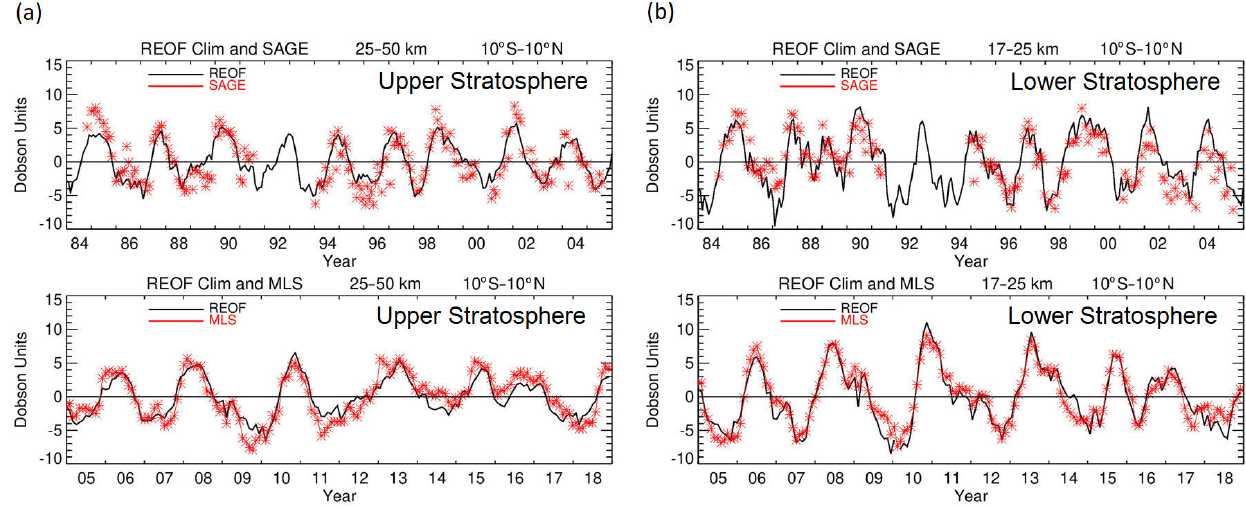
Figure 7. (a) The top panel is zonal-mean upper-stratospheric column ozone (in Dobson units) for the REOF climatology (black curve) and deseasonalized SAGE II (red asterisks) spanning from 1984 to 2005 and averaged between 10 ◦ S and 10 ◦ N. The SAGE data are deseasonalized monthly zonal means. All column amounts are calculated by integrating ozone profiles for Z ∗ = 25–50km ( ∼ 28 to 1hPa). The bottom panel is the same as the top panel but with MLS in place of SAGE and for the time period from 2005 to 2018. The panels in (b) are the same as those in (a) but for the lower stratosphere with Z ∗ = 17–25km ( ∼ 88 to